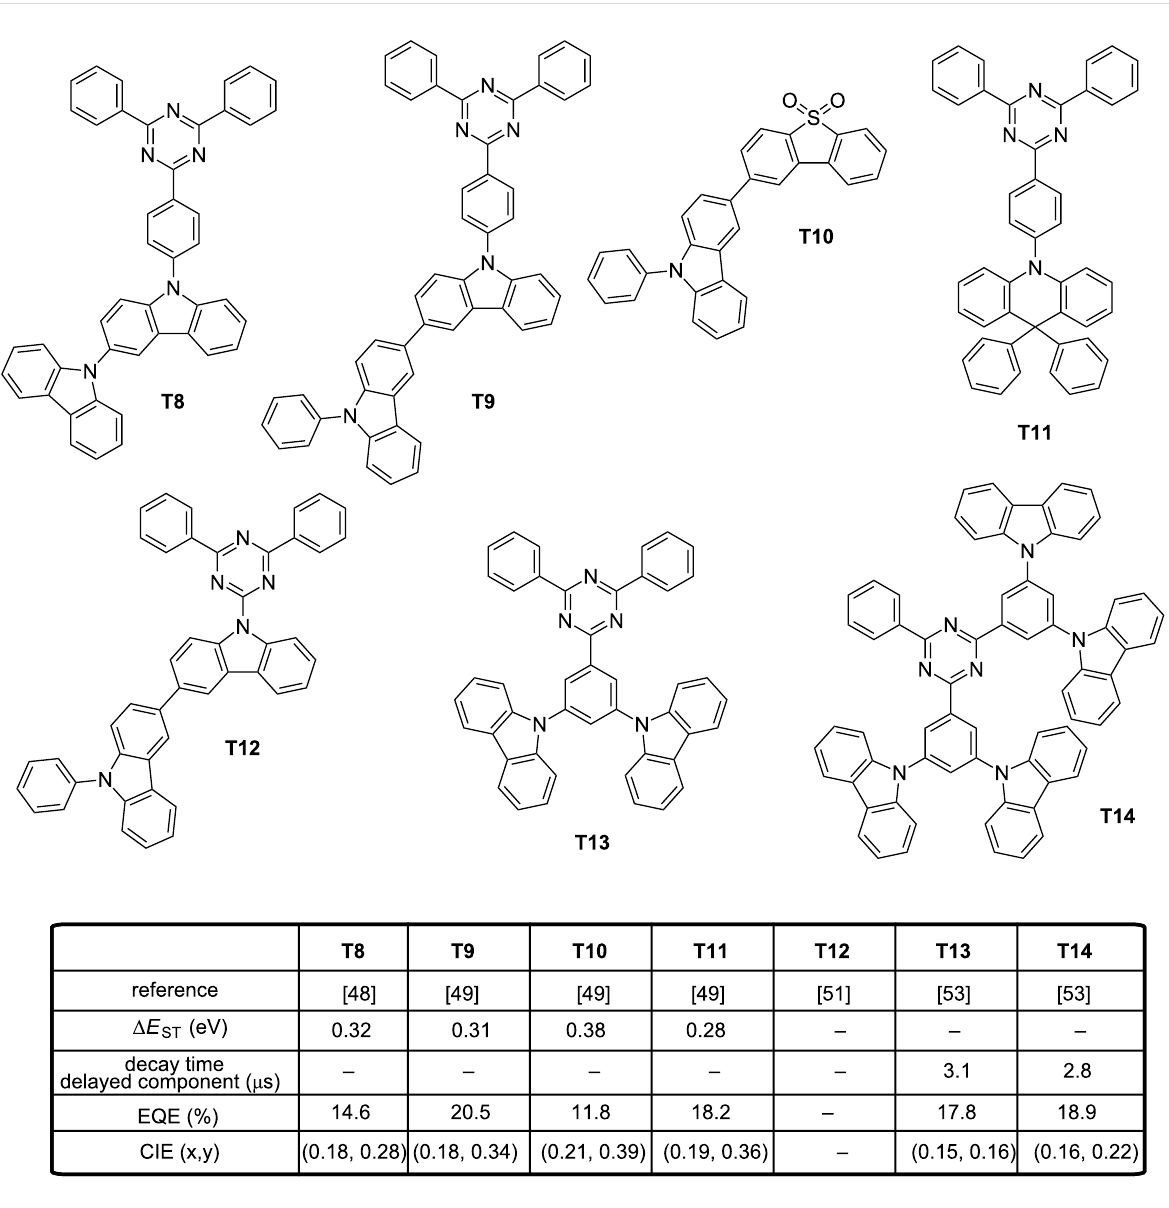
being increased. The low efficiency roll-off of T16 -based devices was assigned to the specific design of the emitter, with the triazine acceptor being totally surrounded by carbazoles. As a result, triplet–triplet annihilation by the Dexter mechanism could be efficiently prevented, enabling to maintain high effi- ciencies at high current density. Although the number of carbazole units increased, no modification of the EL position was detected, the emission peaking at 467 and 468 nm for T15 - and T16 -based devices. In the same spirit, other authors exam- ined the possible impact of the substitution pattern of the carbazole unit on the photophysical